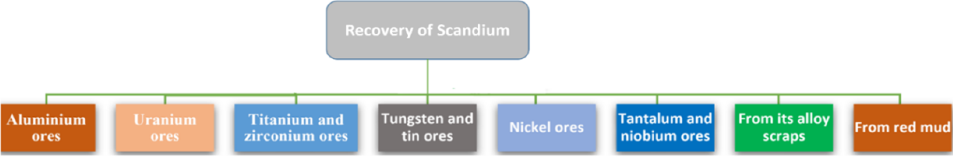
Figure 5. Scandium recovery from different sources.